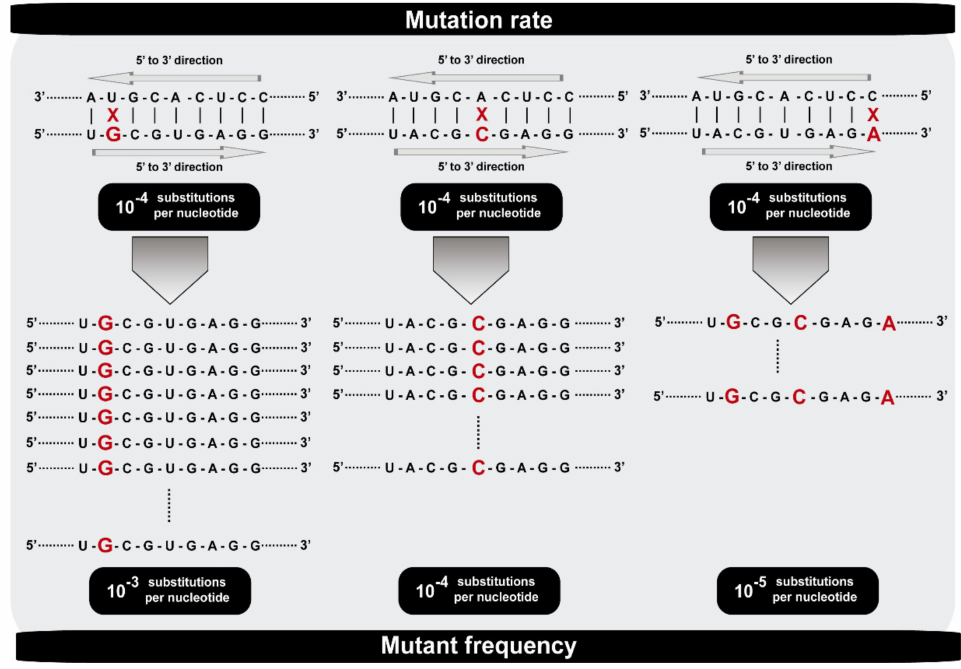
Figure 1. Scheme that illustrates the difference between mutation rate and mutant frequency. Residue U (on the left), A (in the middle), and C (on the right) can be misread to incorporate a G (on the left), C (in the middle), or A (on the right) in the complementary strand at a rate of 10 − 4 substitutions per nucleotide in all cases. The replicative capacity of the newly G, C, and A templates determines the different mutant frequencies with 10 − 3 , 10 − 4 , and 10 − 5 substitutions per nucleotide,